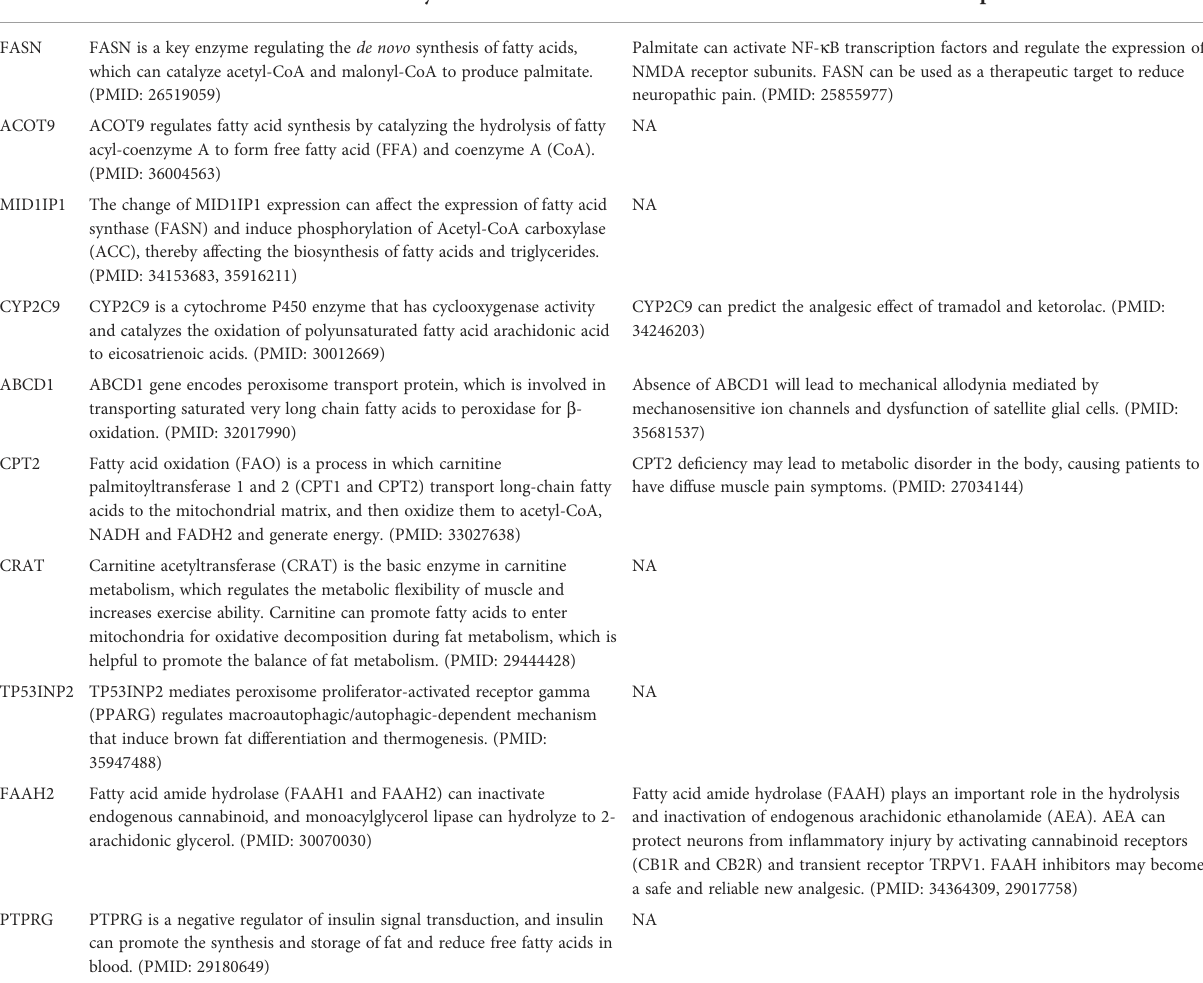
TABLE 1 The summary of the pain dissection of the FMGs signature. Gene Association with fatty acid Association with pain